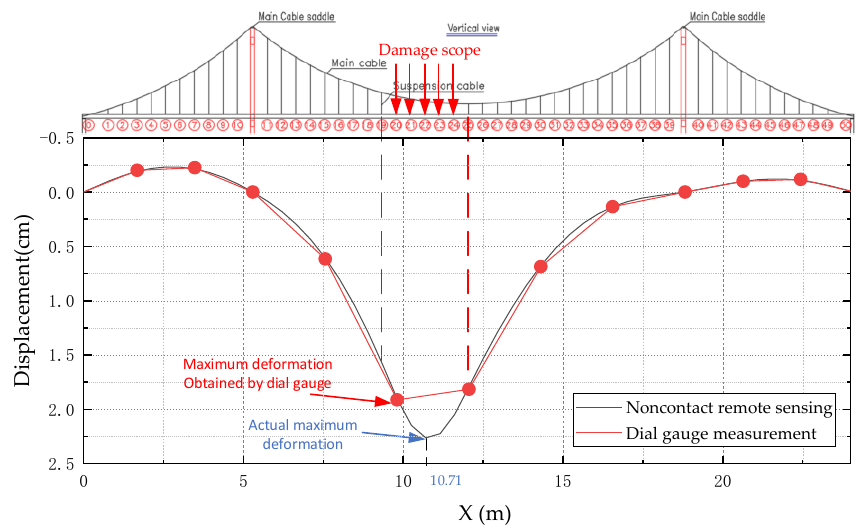
Figure 19. Comparison of girder alignment obtained by two measure method under condition 6. Appl. Sci. 2020 , 10 , x FOR PEER REVIEW